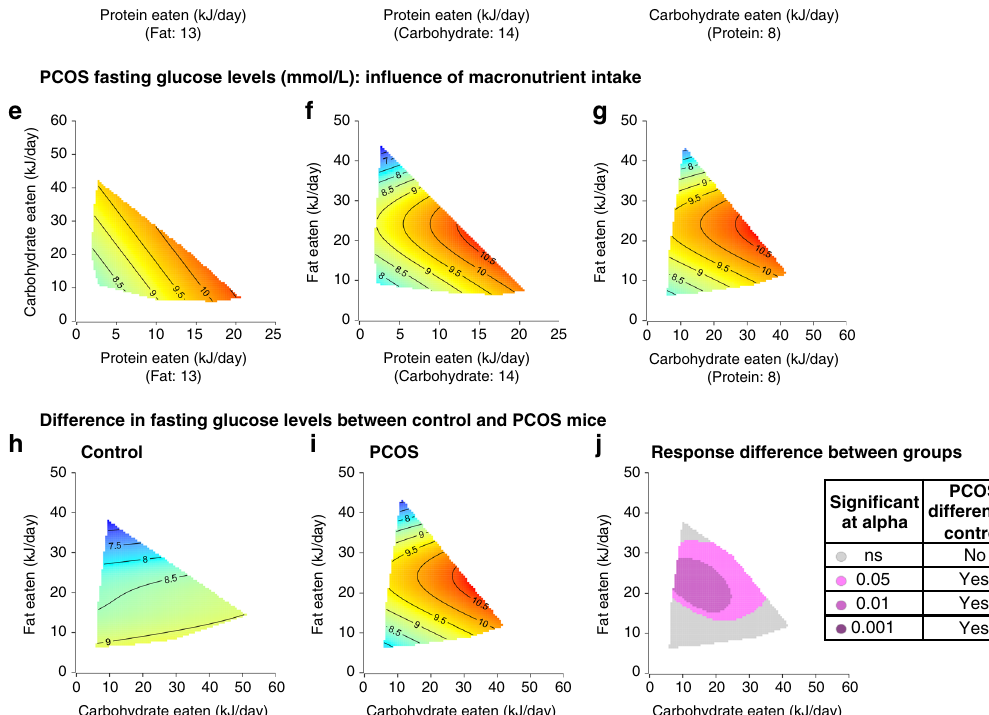
Fig. 6 Increased fasting glucose levels in PCOS overall cannot be ameliorated by dietary interventions. a Fasting glucose levels, showing a signi fi cant increase in basal glucose levels in PCOS mice compared to control mice ( P = 0.04). Signi fi cance determined by Mann – Whitney test, asterisk (*) indicates P -value <0.05. Data presented as violin plots, doted lines indicate the median and dashed lines the 25 and 75% percentiles. b – g 3D GAM response surfaces displaying the relationship between macronutrient intake (kJ/day) and glucose levels in control ( b – d ) and PCOS mice ( e – g ). Red areas indicate the greatest value for each response, which then decreases to the lowest value as the color shifts to blue. Control mice exhibited a decrease in fasting glucose with increasing fat intake while PCOS mice display overall increased levels of fasting glucose. h – j Response surfaces showing the effects of C and F intakes on fasting glucose levels in control mice ( h ), PCOS mice ( i ) and response difference ( j ), demonstrating that fasting glucose levels in PCOS mice are comparable to control mice when fat intake was reduced to <12 kJ/day. On the other hand, fasting glucose is not able to be modulated by diet when PCOS mice ingested F in the range of 12 – 32 kJ/day, indicating that PCOS pathology hinders serum fasting glucose levels in PCOS mice with higher F intakes. a – j n = 93 control and 94 PCOS